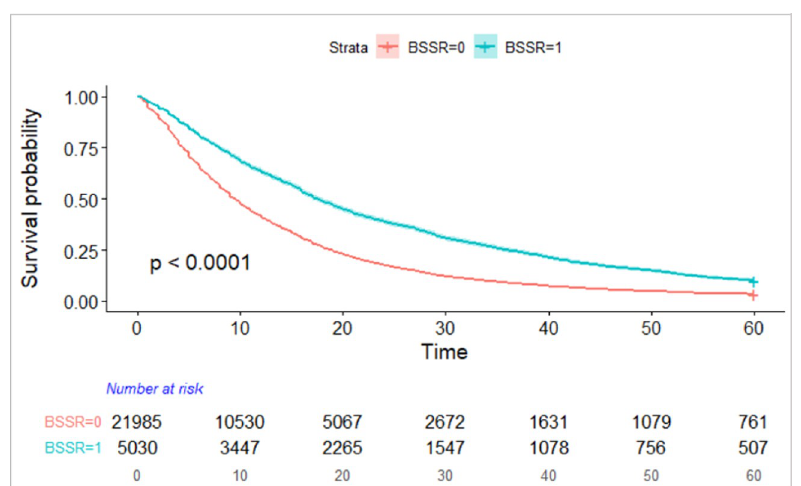
Fig 1. KM survival curve of time to first publication for BSSR and non-BSSR